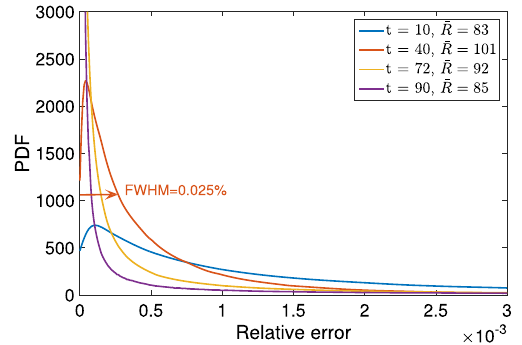
Fig. 12 Plots showing the probability density functions (PDF) of the relative error between the original CO 2 concentration field and its constructed value using StOMP. The CO 2 concentration field is represented on a 1600 (cid:6) 1600 regular grid distributed on 10 (cid:6) 10 processes for t ¼ 10 and t ¼ 40 (resp. 3200 (cid:6) 3200 regular grid distributed on 20 (cid:6) 20 processes for t ¼ 72 and t ¼ 90). Results are reported for a local StOMP reconstruction with a wavelet order w ¼ 5 where the compression ratios were optimally estimated. The plot shows how the FWHM is computed, and the rest of these values are reported in Table